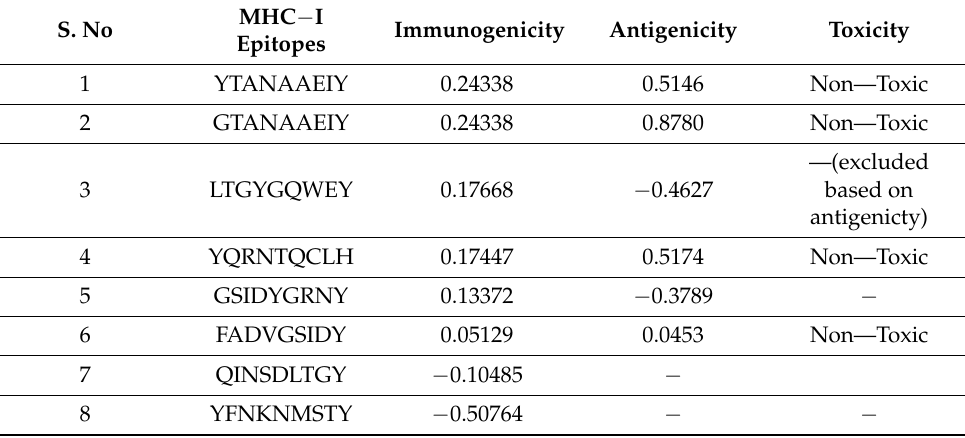
Table 1. MHC-I finalized epitopes along with predicted immunogenicity, antigenicity, and